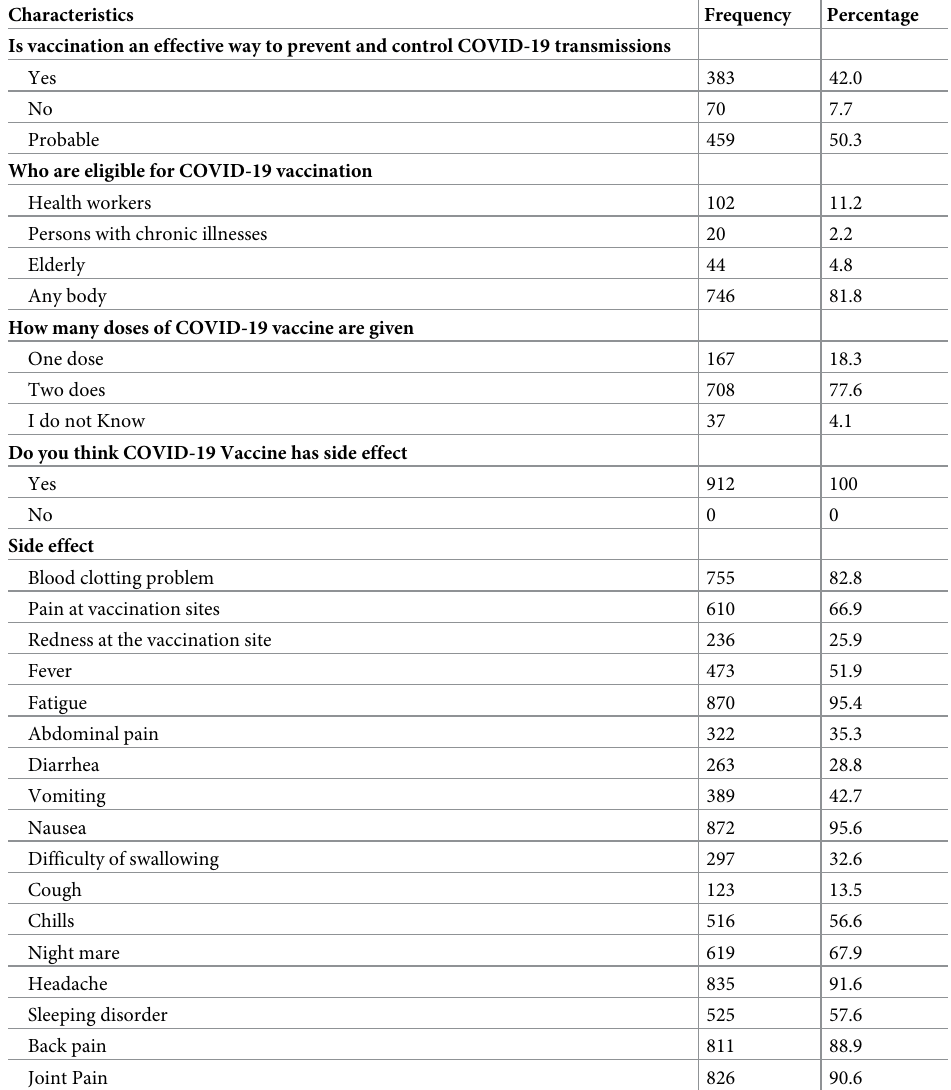
Table 2. Participants knowledge about COVID-19 Vaccine for the study of post COVID-19 vaccine evaluations in Oromia region, Ethiopia, 2021.